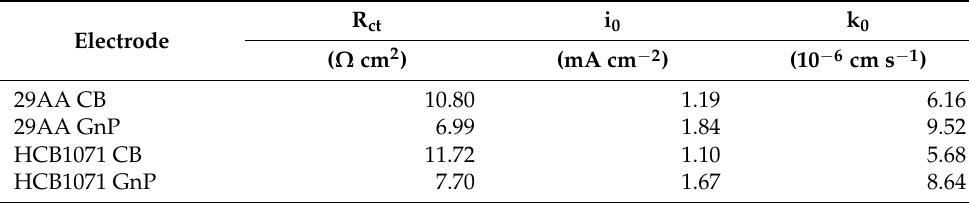
Table 3. Kinetic parameters for enhanced-surface-area electrodes. Data taken from Figure 7.